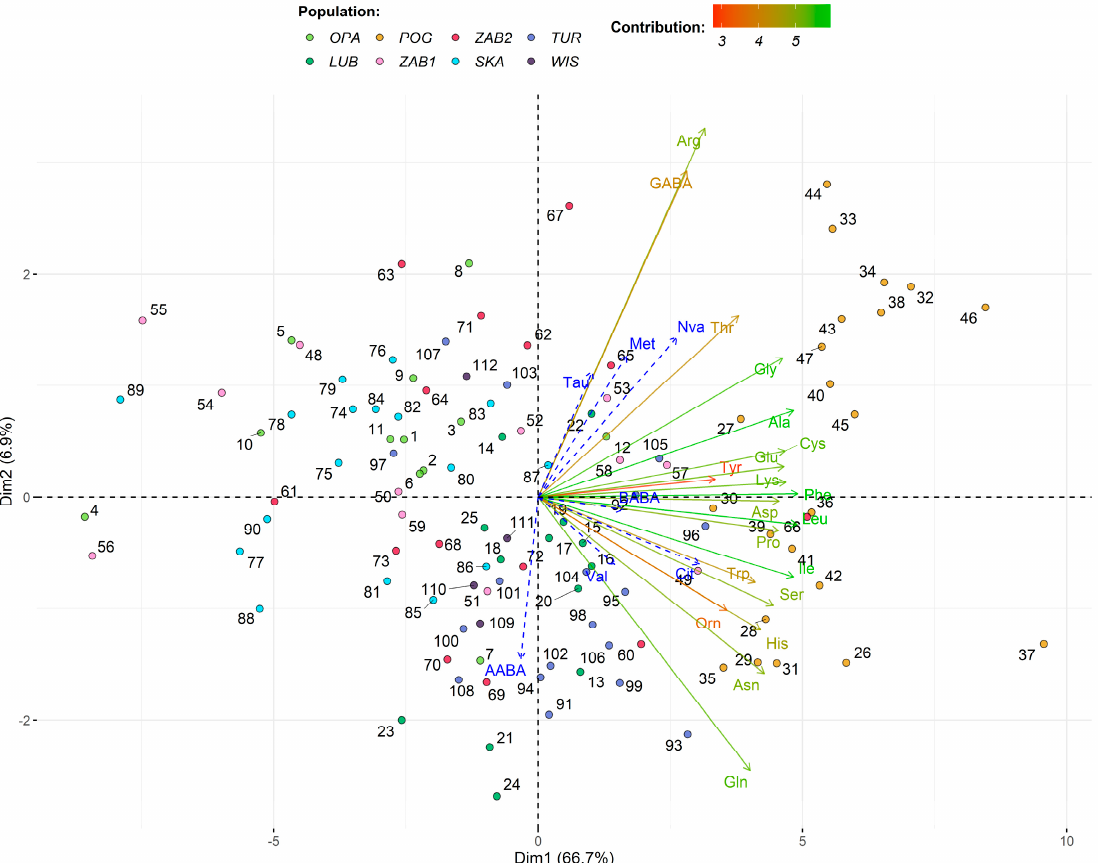
Figure 3. Biplot of amino acid profiles for Neottia ovata populations, showing the first two dimensions/factors (Dim1-2) of PCA that together explain 73.5% of the variance. Biplot vectors indicate the strength and direction of factor loading for the first two factors. Vectors of supplementary variables are in blue. Individuals (populations) are color-coded and labeled with a number corresponding to Id used in Table